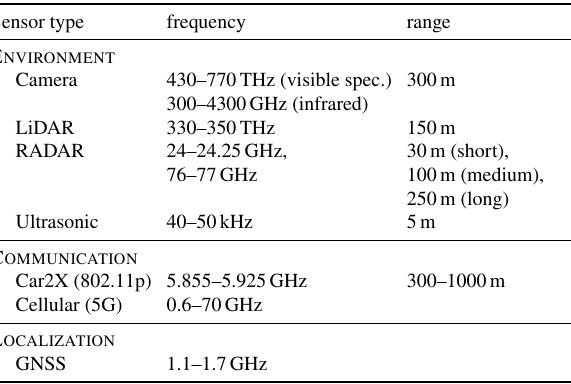
Table 1. Relevant vehicle sensors for automated driving (properties depend on model, manufacturer and country)